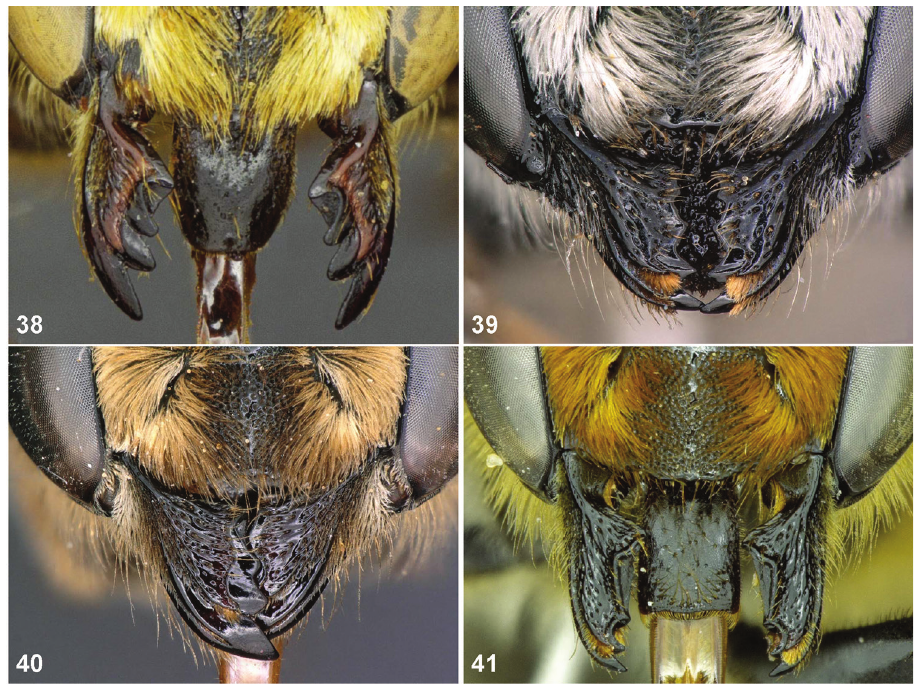
Figures 38–41. Female clypeus and mandibles, front view. 38 Megachile ( Eurymella ) patellimana 39